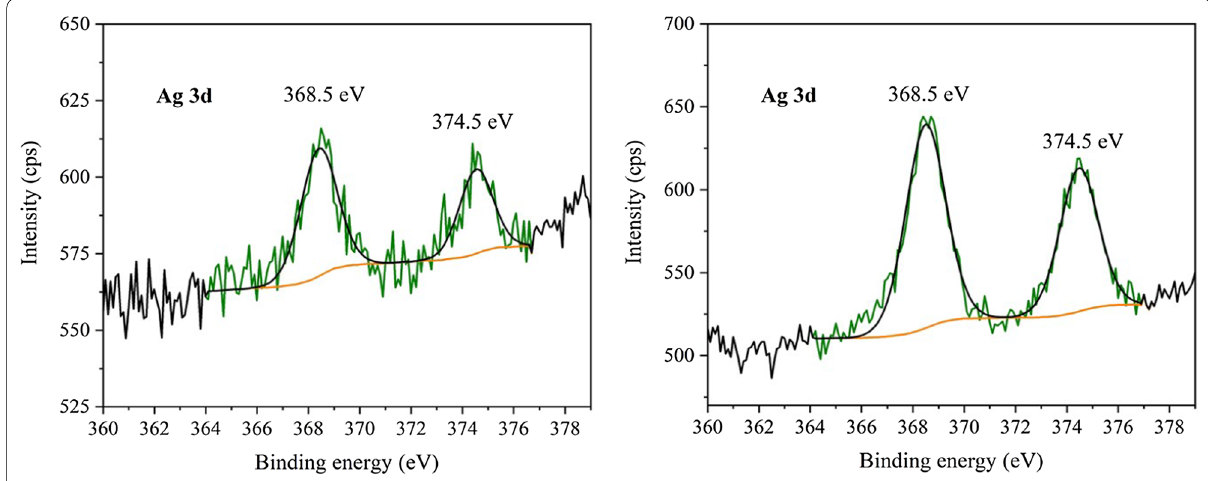
Fig. 6 XPS spectra of Ag 3d of Ag + adsorbed on CNE (left) and AgCNE4